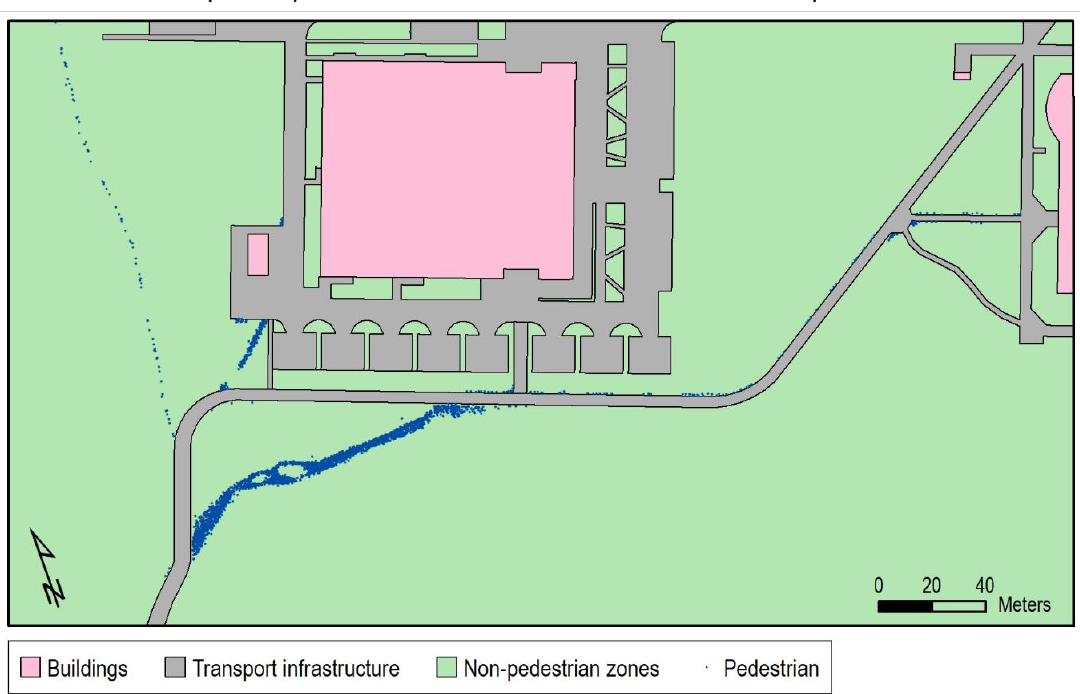
Figure 6. The map of land use with the location of pedestrians outside the transport infrastructure: the chorochromatic method (qualitative data) and the dot method (quantitative data).